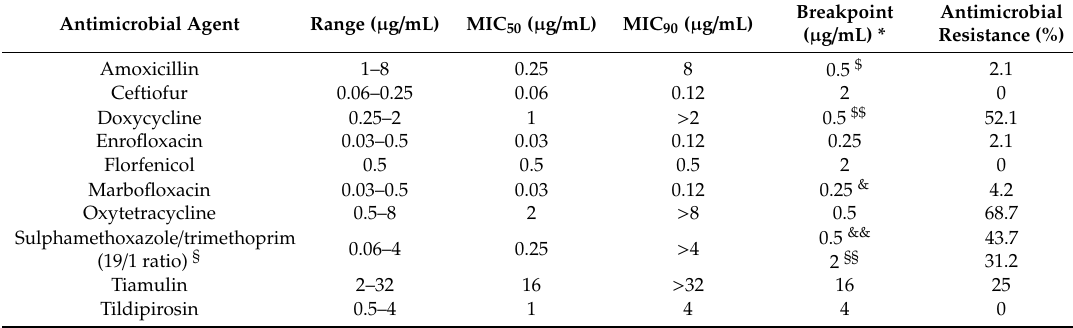
Table 1. MIC (minimum inhibitory concentration) range, MIC 50 , MIC 90 and percentage of resistant Pasteurella multocida isolates recovered in Spain between 2017 and